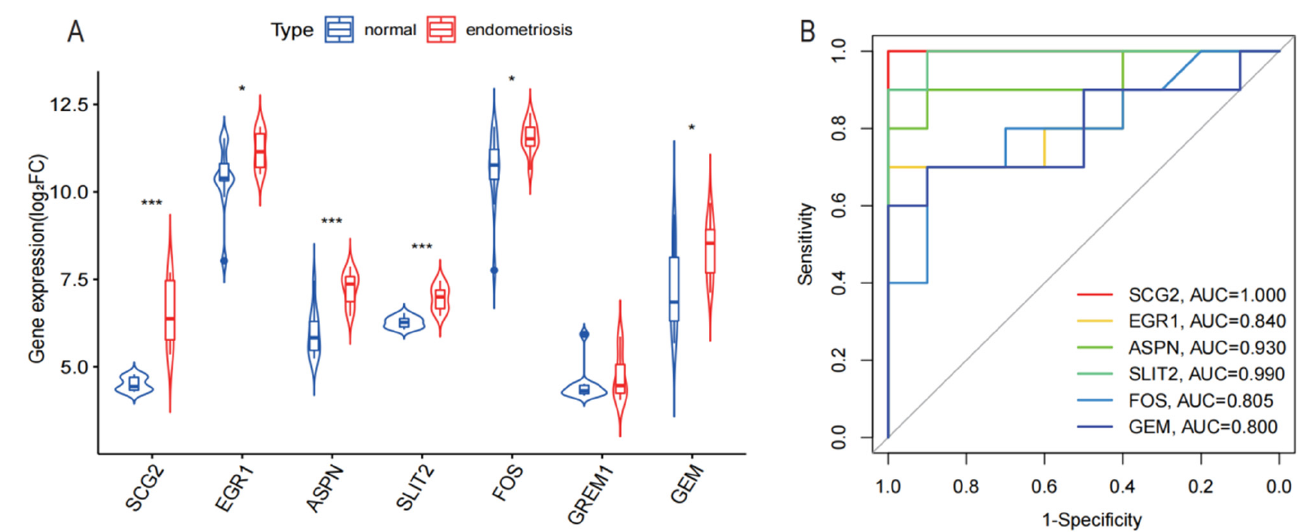
Figure 4. Validation of diagnostic markers by external dataset. ( A ) Validation of the expression of seven potential biomarkers in the 7305 dataset. ( B ) Verification of the diagnostic effectiveness of six biomarkers in the 7305 dataset (* p < 0.05, *** p < 0.001). Three novel biomarkers (SCG2, ASPN, and GEM) were screened, and the findings are displayed in Figure 5A. The genes (EGR1, SLIT2, and FOS) were rejected because they were previously correlated with the development of endometriosis in the literature. The relative expression of mRNA for ASPN and GEM was found to be higher in